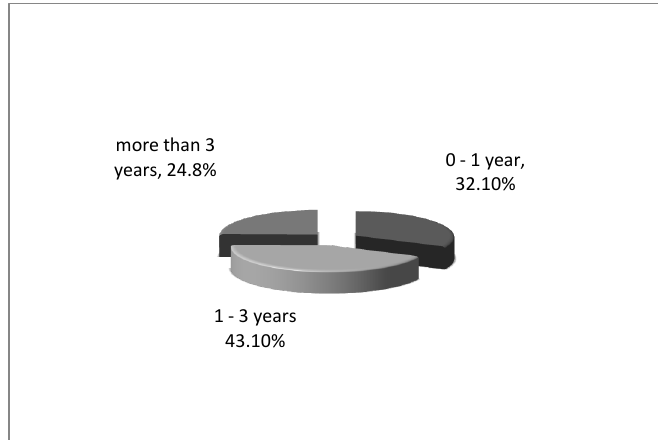
FIGURE 5: Length of experience as a waiter (2008) Source: Survey data